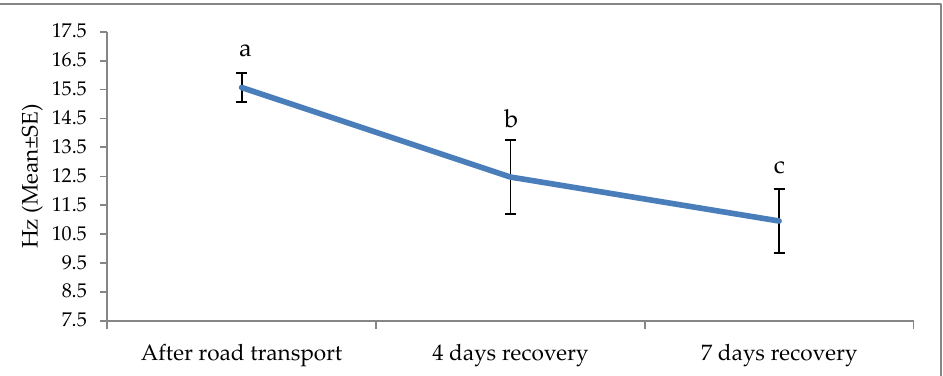
Figure 8. Effects of road transport on total power (ptot) of the EEG in cattle. The number of animals used in each sampling point was 24 heifers. Means with different letters are significantly different at p < 0.05.